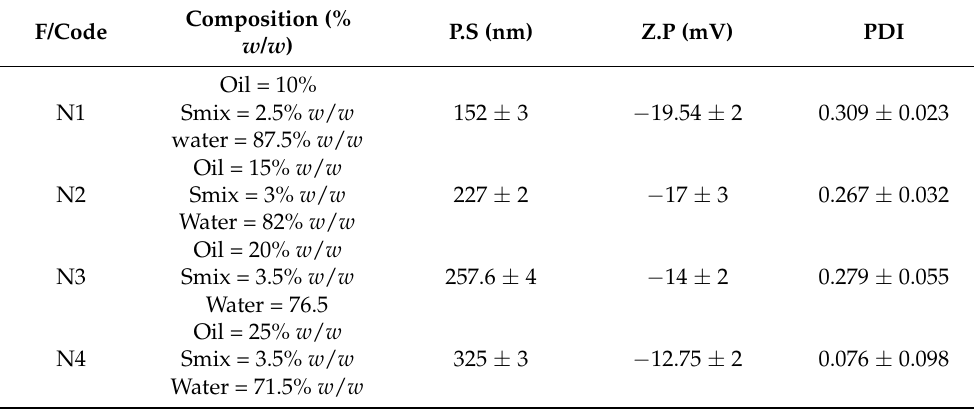
Table 2. Particle size, zeta potential, and polydispersity index of the four formulations of nanoemul- sion.